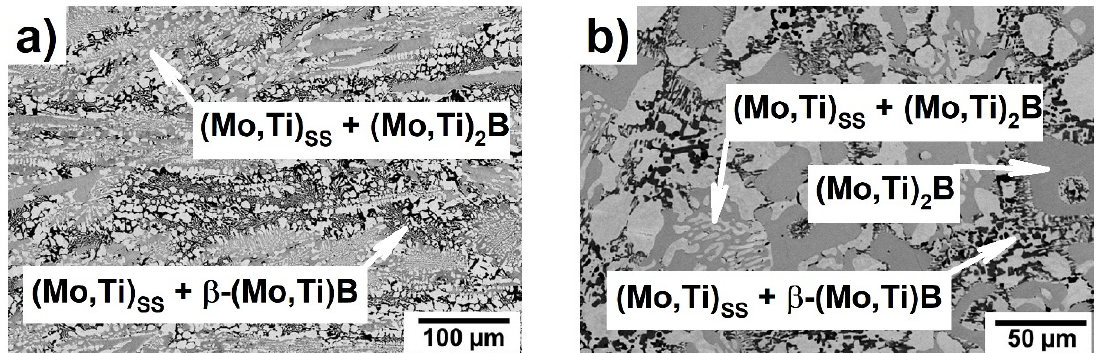
Figure 4. SEM-BSE micrograph of the directionally solidified Mo-17.4Ti-22.1B alloy: ( a ) longitudinal; ( b ) transverse.